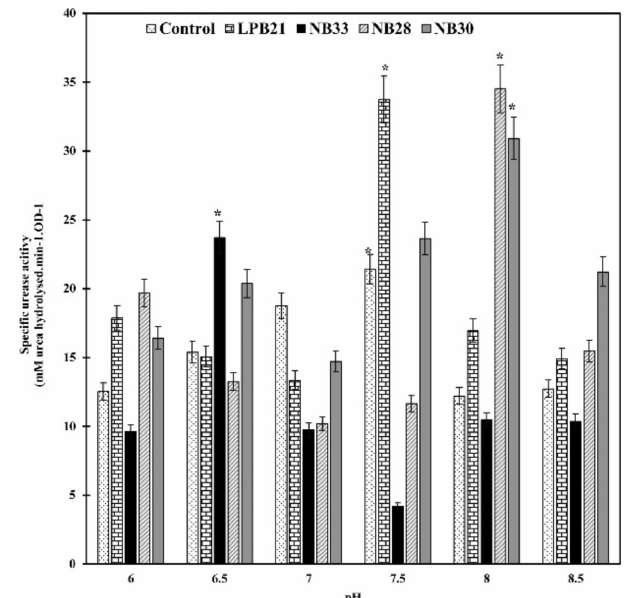
Figure 14. Effect of different initial medium pH on urease activity. Control: S. pasteurii DSM 33; LPB21: closest match Sporosarcina pasteurii fwzy14; NB33: closest match Sporosarcina pasteurii WJ-4; NB28: closest match Sporosarcina pasteurii WJ-5; NB30: closest match Sporosarcina pasteurii fwzy14.